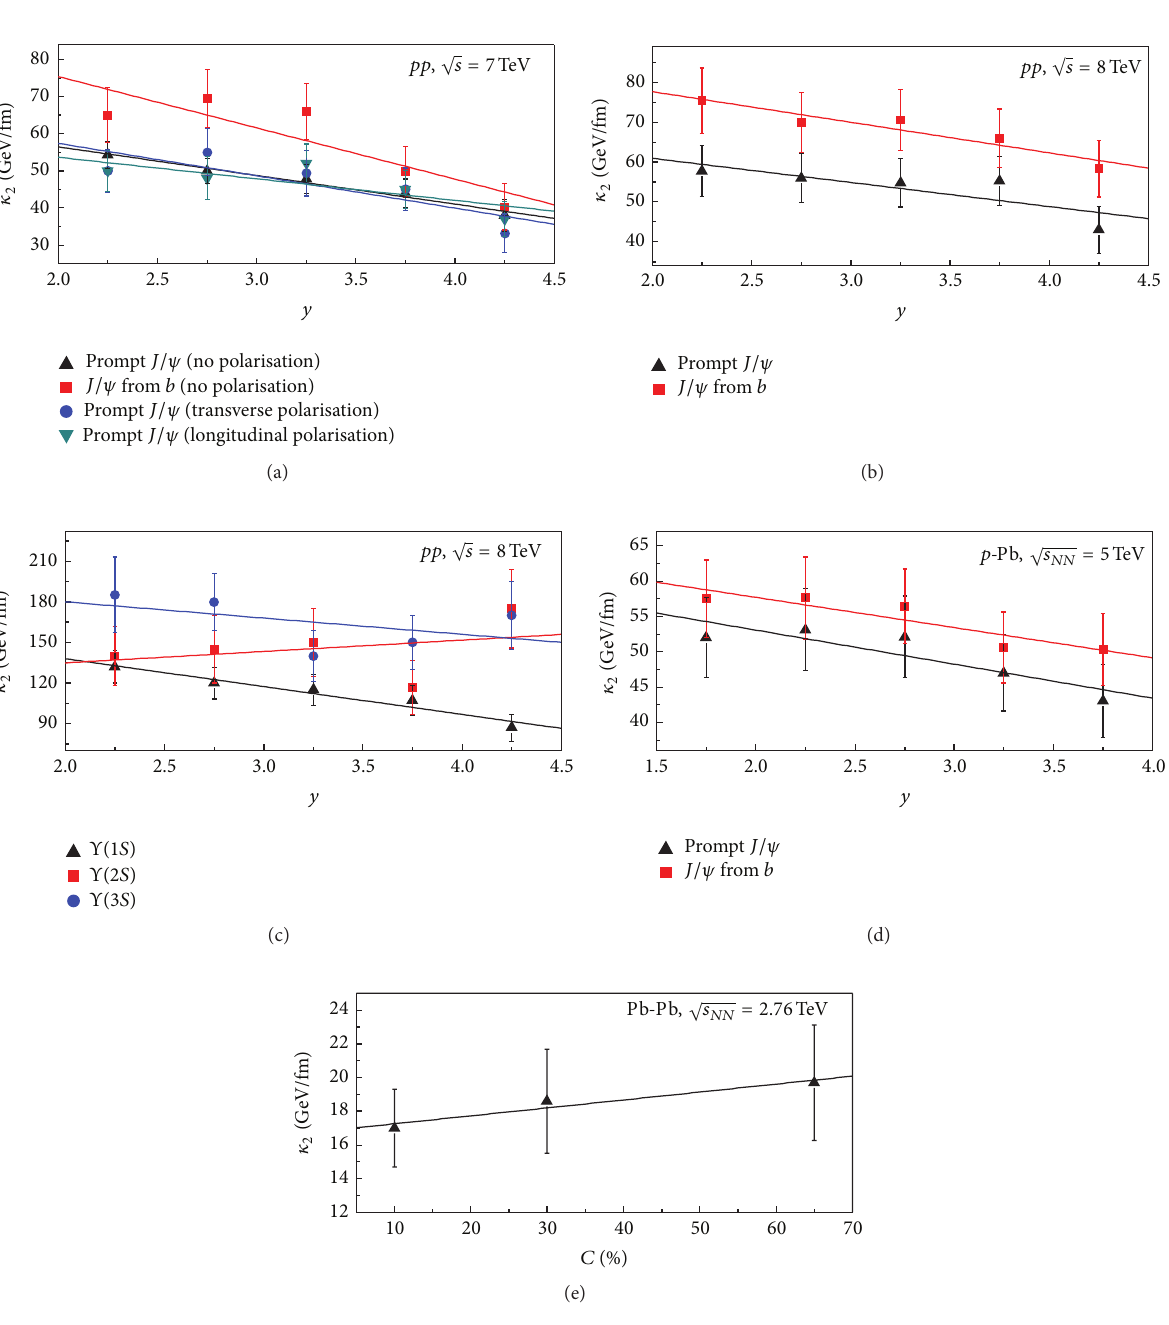
Figure 11: The same as Figure 6 but showing the results for 𝜅 2